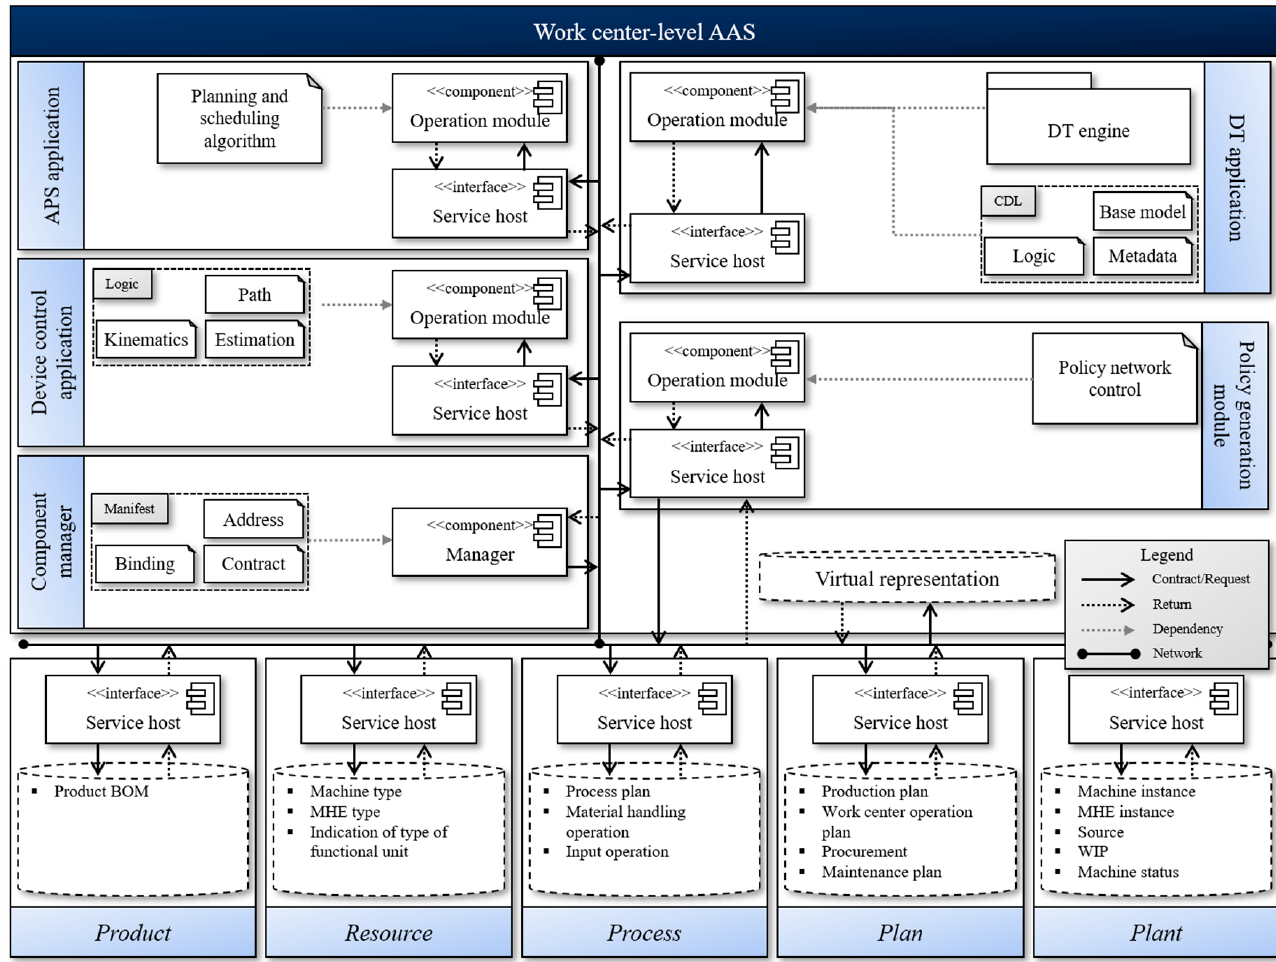
Figure 3. CPPS architectural framework for resilient production control in MSF.